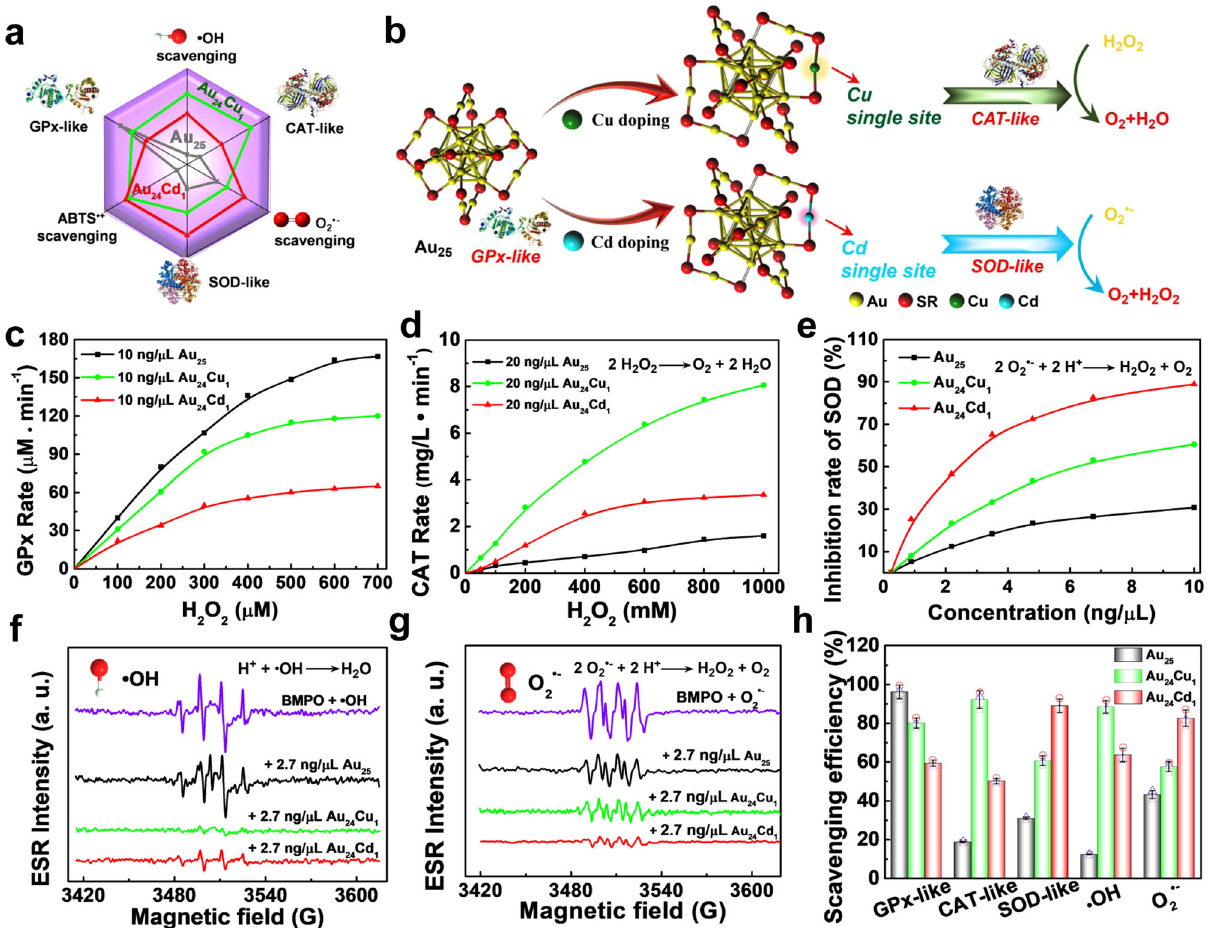
Fig. 3 Enzyme-mimetic properties and ROS scavenging activity of Au 25 clusterzymes. a The radar map of enzymatic activities and free radical scavenging abilities of various clusterzymes. b Schematic illustration of catalytic selectivity of the clusterzyme system. Au 25 exhibits signi fi cant superiority in GPx-like activity; Au 24 Cu 1 shows advantages in the CAT-like activity through the Cu single active site; Au 24 Cd 1 preferably exhibits the SOD-like activity via the Cd single active site, each demonstrating a unique catalytic selectivity. c GPx-, d CAT-, and e SOD-like activities of Au 25 , Au 24 Cu 1 , and Au 24 Cd 1 . ROS scavenging activities of Au 25 , Au 24 Cu 1 , and Au 24 Cd 1 clusterzymes for f (cid:129) OH and g O 2 (cid:129) − studied by the ESR spectroscopy. BMPO is used as the ROS- capturing agent and the sources of (cid:129) OH and O 2 (cid:129) − are H 2 O 2 and KO 2 , respectively. h Corresponding quanti fi cations of the scavenging ef fi ciencies ( n = 3 independent experiments, data are presented as mean ±